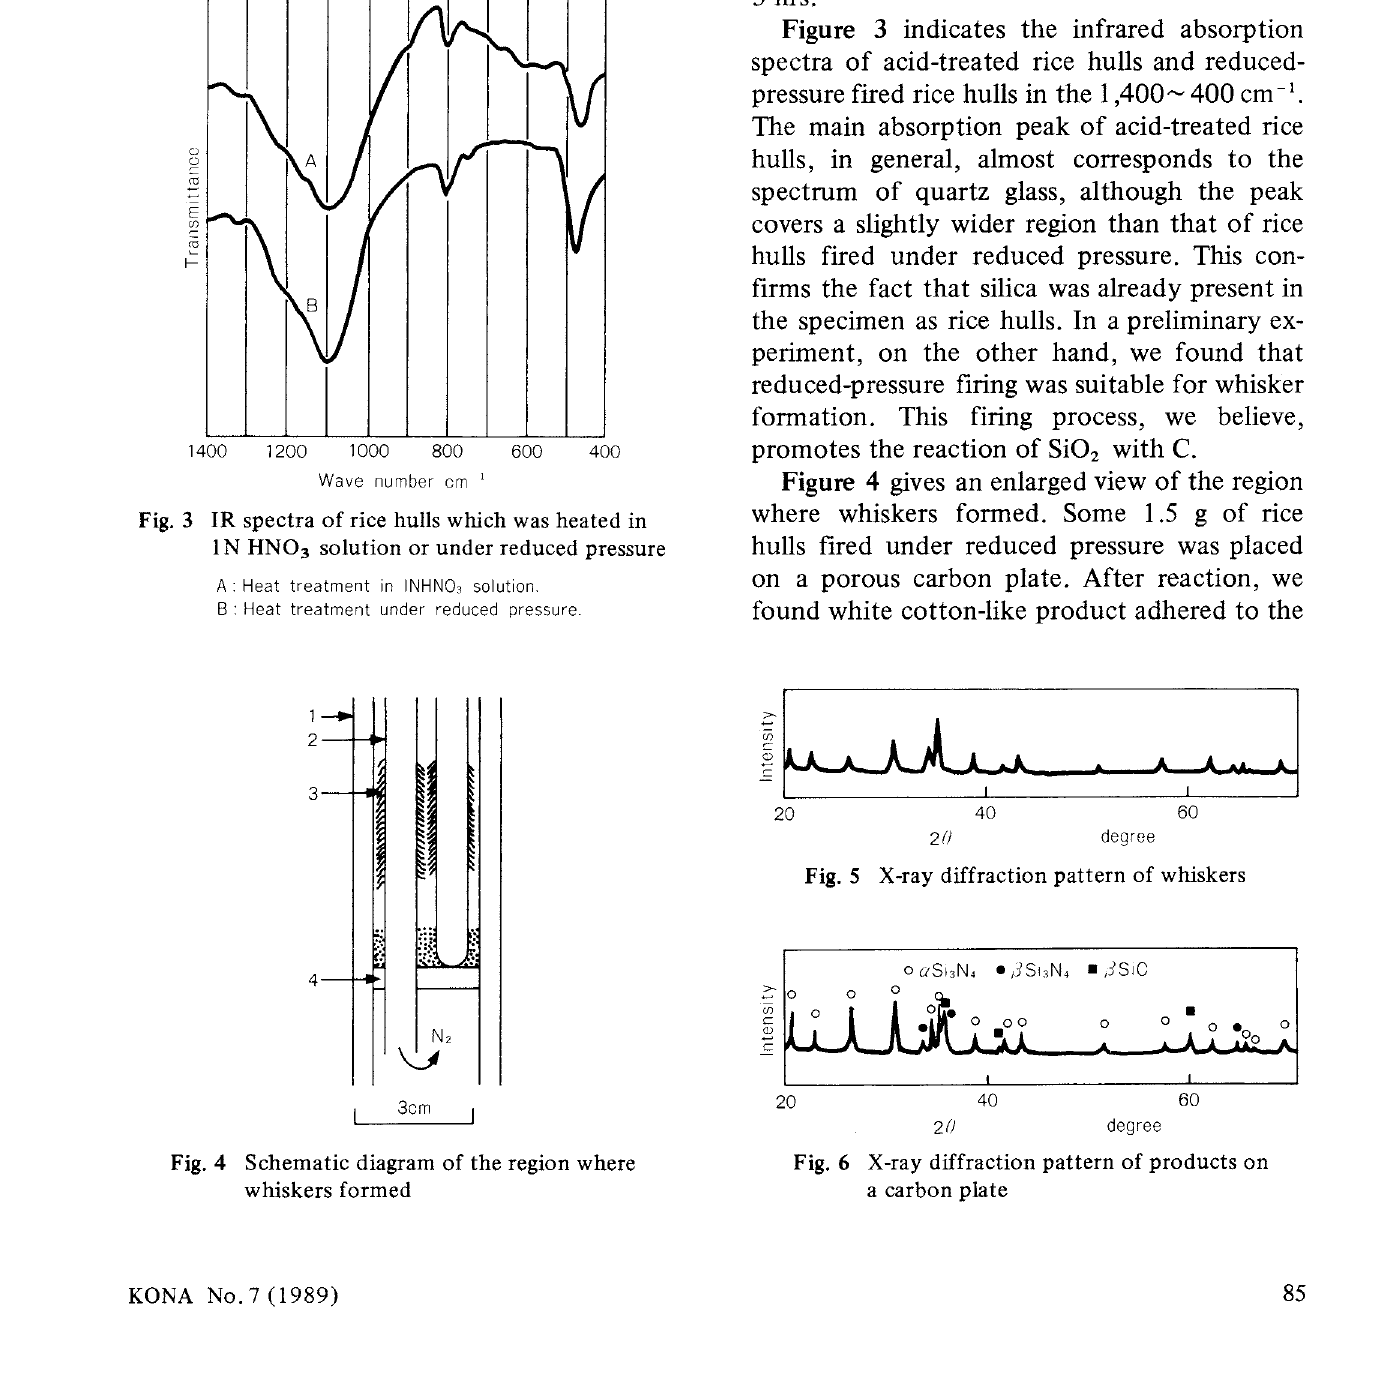
Fig. 6 X-ray diffraction pattern of products on a carbon